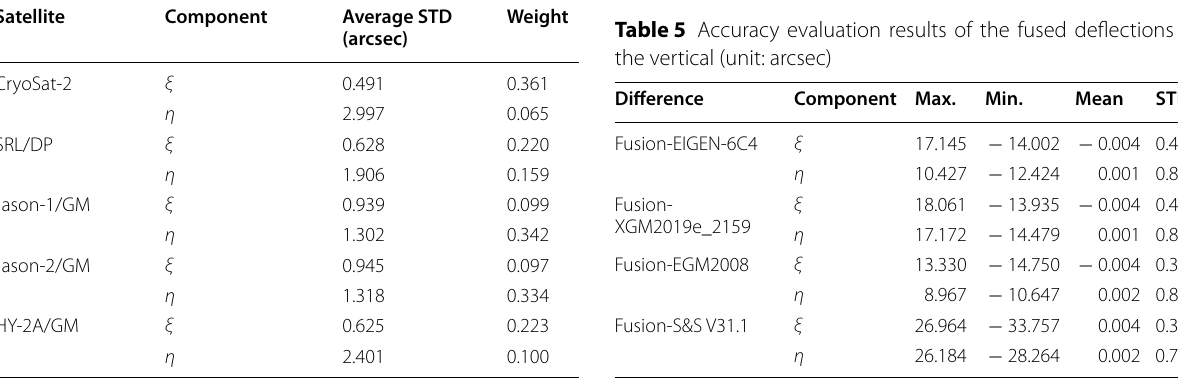
Table 4 Average error STD and weights of each satellite observations